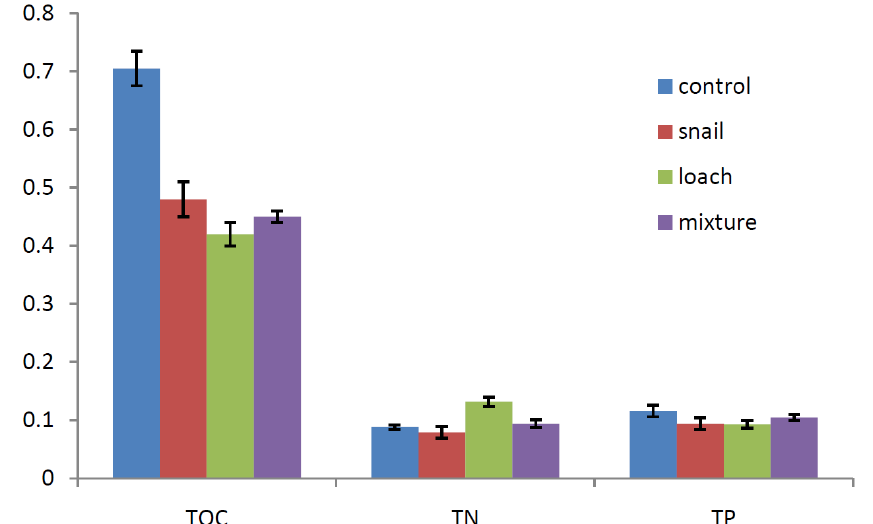
Figure 4. Nutrient and organic matter content of the sediment (average ± standard error) in the treatment and the control at the end of the